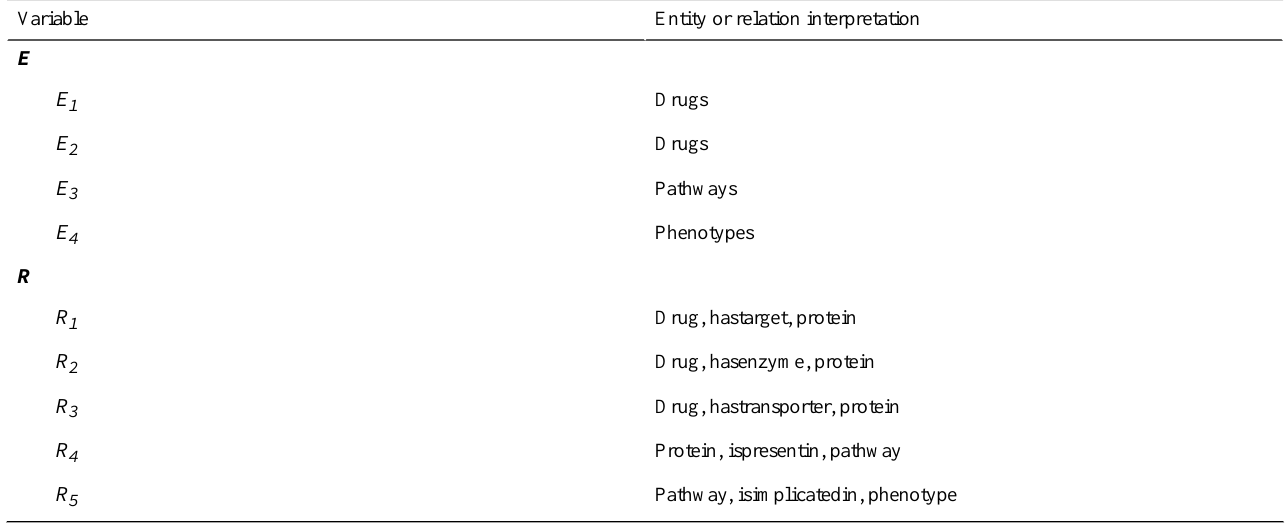
Table 1. Entities and relations of basic triples in Kamdar and Musen [27].